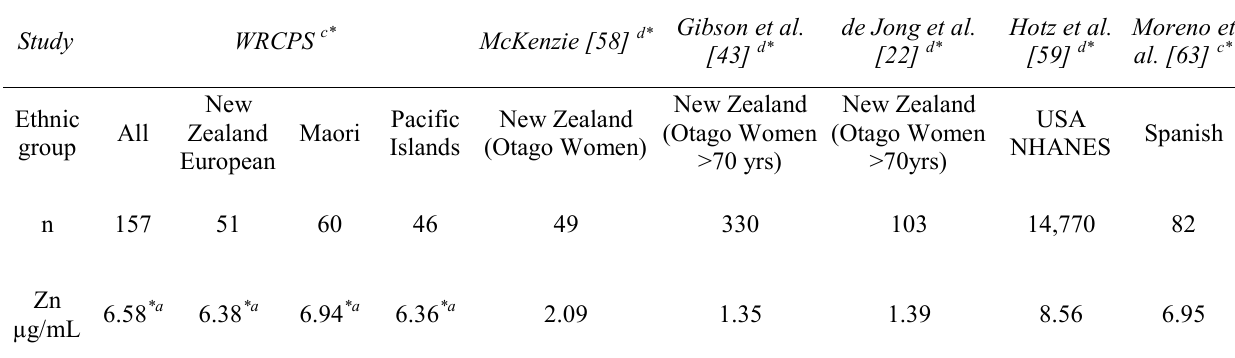
Table 4: Blood Zn level by ethnicity of the WRCPS, compared with other community-based